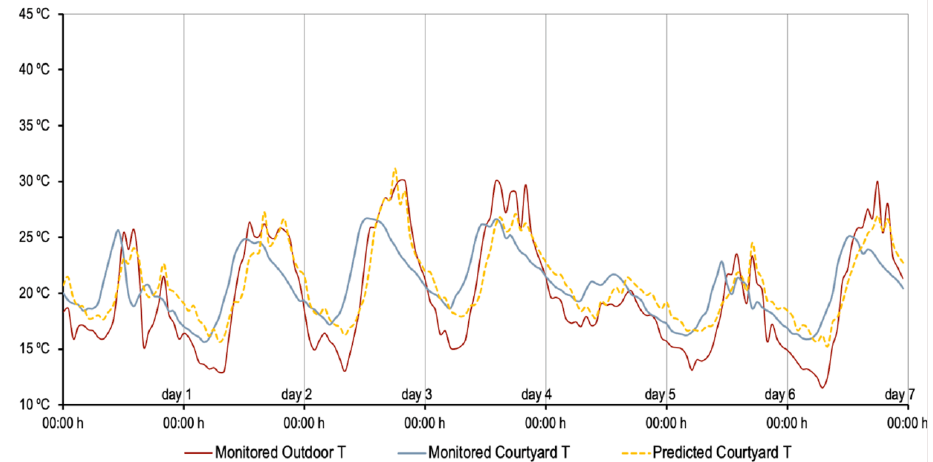
Figure 7. Example 3.0.2. Predicted temperature versus monitored and outdoor temperatures inside a ARII.1 courtyard.